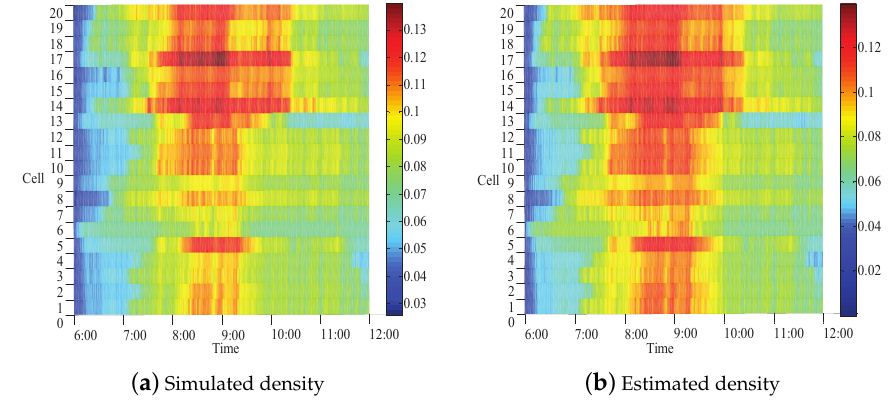
Figure 8. Time-space diagram of traffic